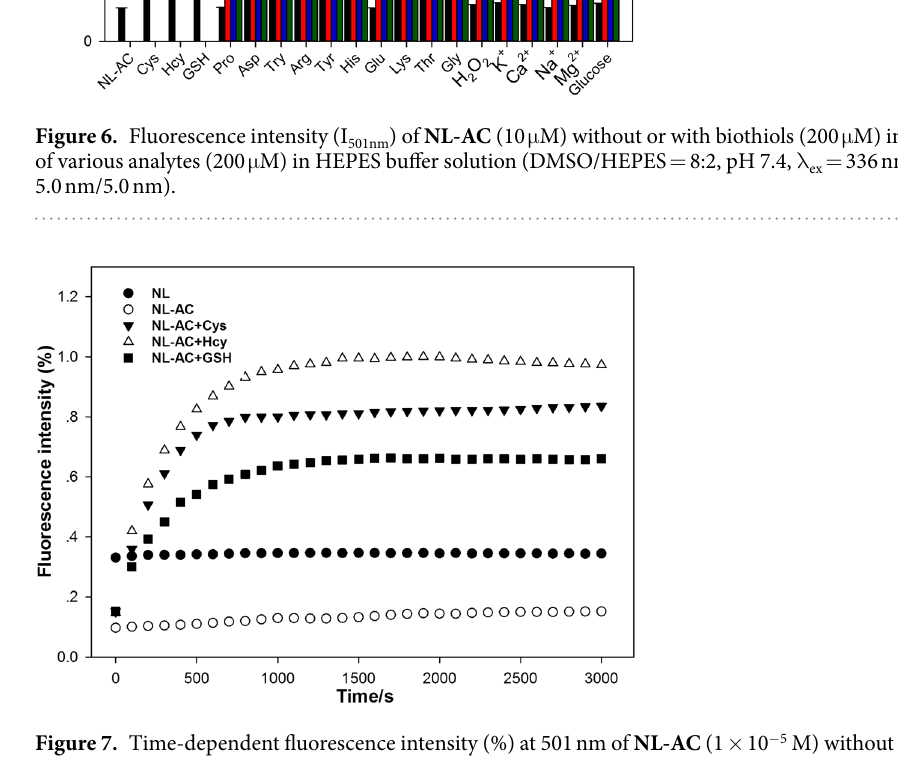
Figure 7. Time-dependent fluorescence intensity (%) at 501 nm of NL-AC (1 × 10 − 5 M) without and with Cys (2 × 10 − 4 M), Hcy (2 × 10 − 4 M) and GSH (2 × 10 − 4 M) in HEPES buffer solution (DMSO/HEPES = 8:2, pH 7.4, λ = 336 nm, slit: 5.0 nm/5.0 ex